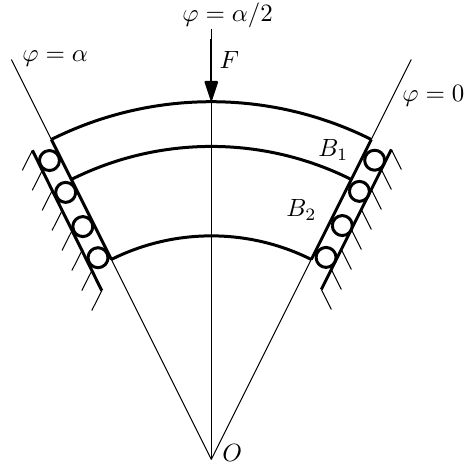
Figure 12: The case of concentrated radial load.